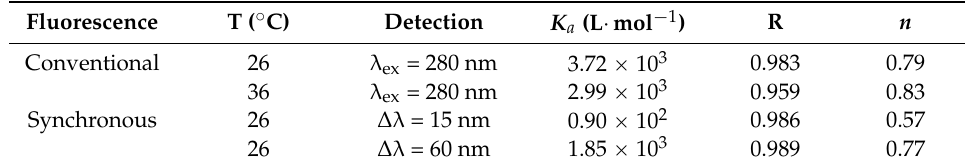
Table 2. Binding reactive parameters of HSA by